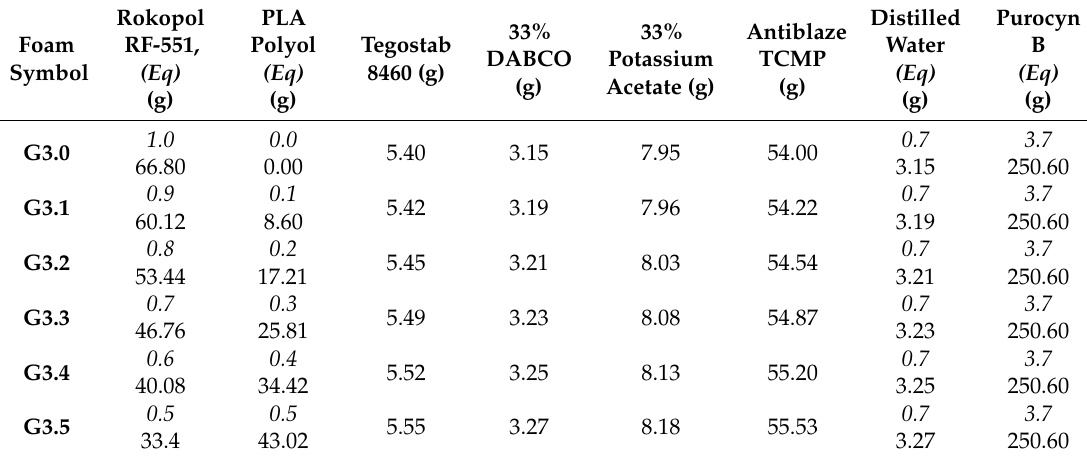
Table 2. Formulation of RPU/PIR foams with